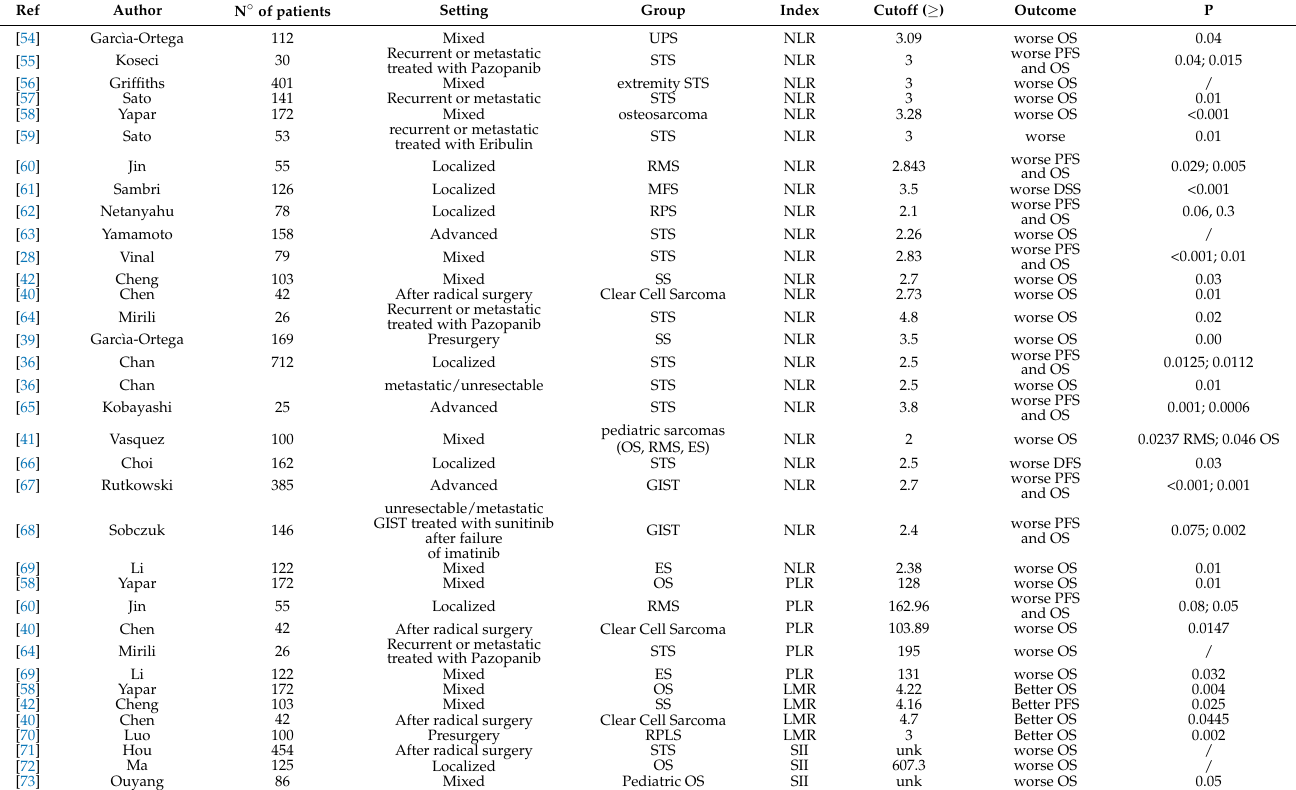
Table 4. Published studies on inflammatory indices in